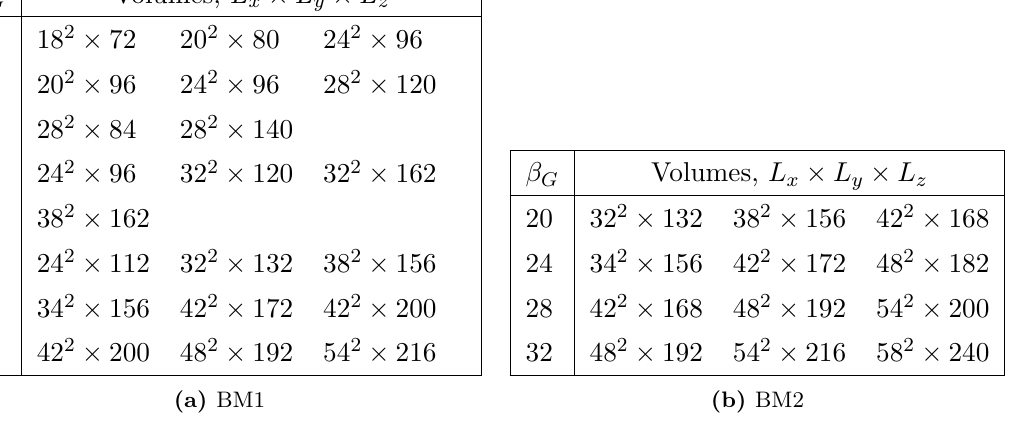
Table 3. Lattice volumes and values of (cid:12) G used in simulations. The volumes are given in units of a 3 . We use lattices cylindrical in the z direction, with the remaining two directions having equal length. In BM2, some scalar degrees of freedom are so heavy that it is necessary to use small lattice spacings (large (cid:12) G ) to fully capture their e(cid:11)ect on the phase transition. Simulations with (cid:12) G = 14 in BM1 are only used in the continuum extrapolation of T c